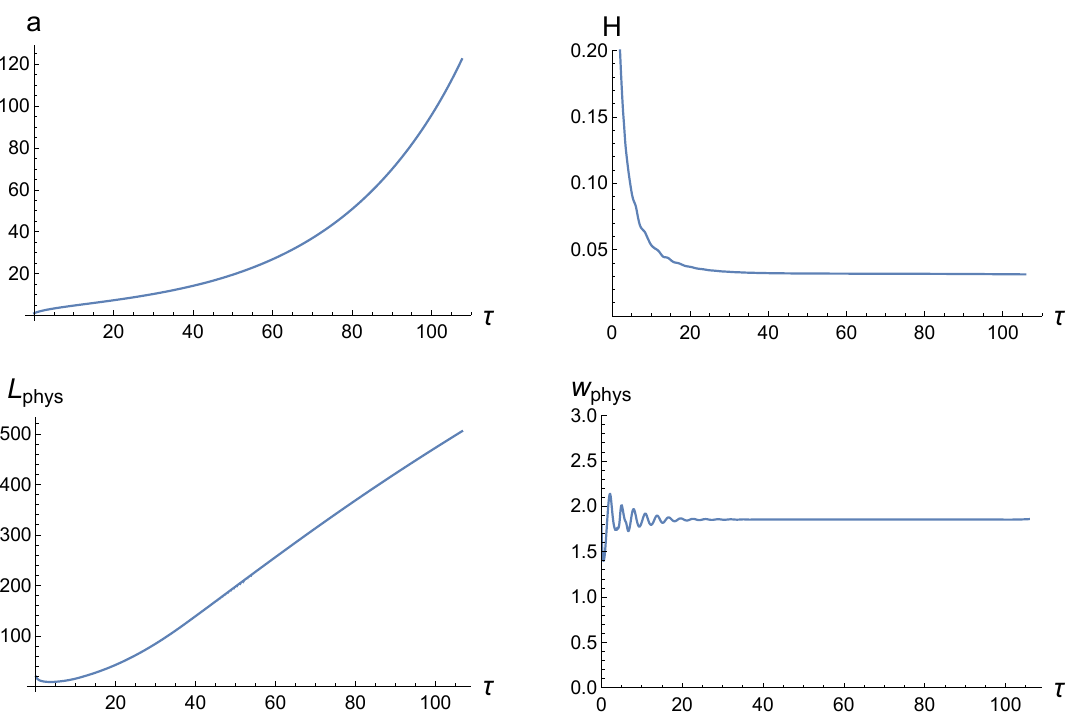
Figure 7 . The scale factor a , the Hubble parameter H , the physical size of the extra dimen- sion L phys , and the physical width of the domain wall w phys as functions of τ . The parameters are chosen as (4.6) and V min = 0